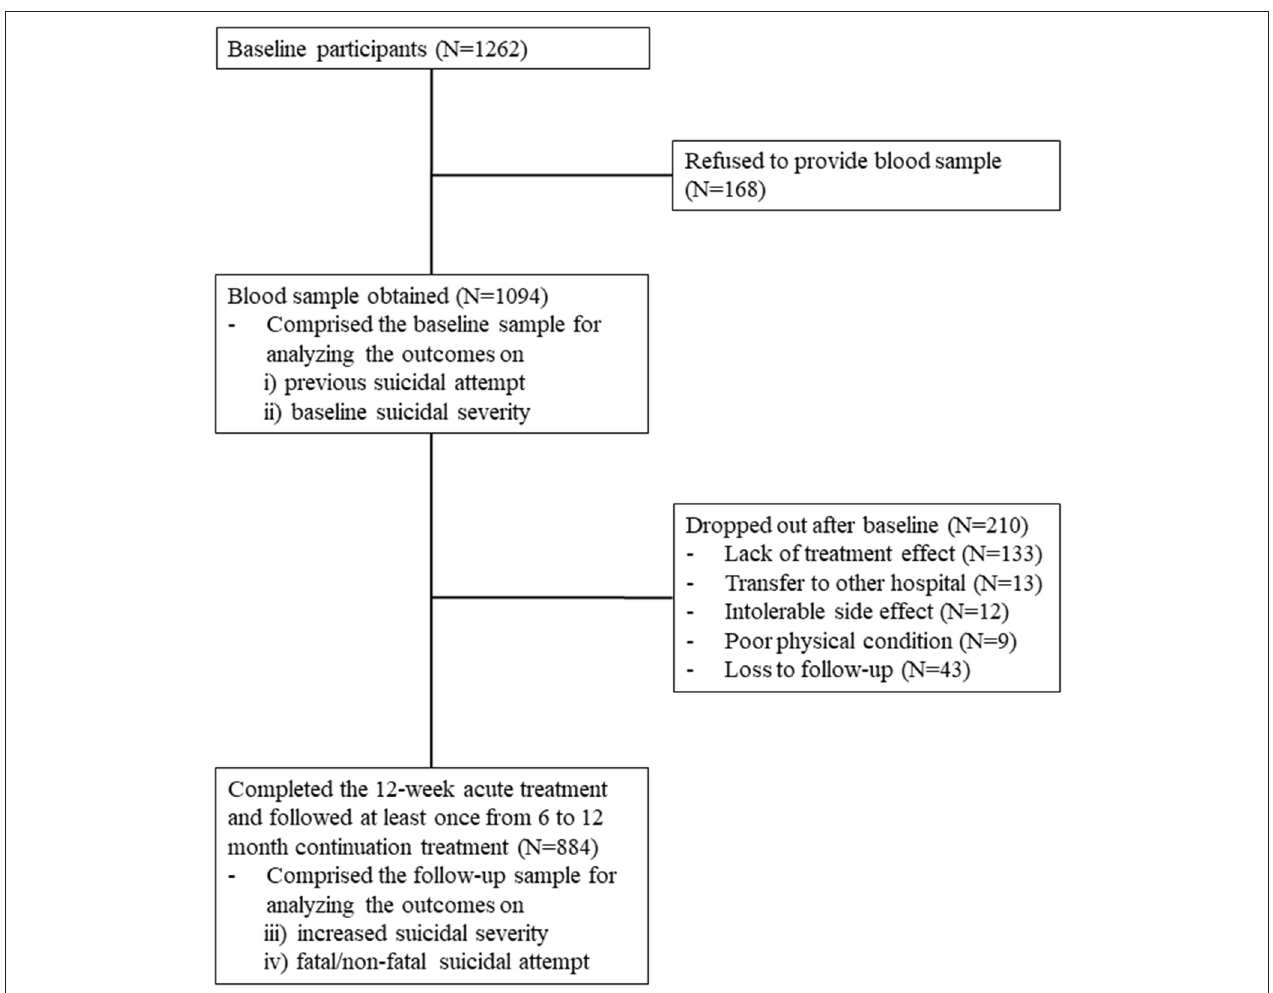
FIGURE 1 | Participant recruitment and